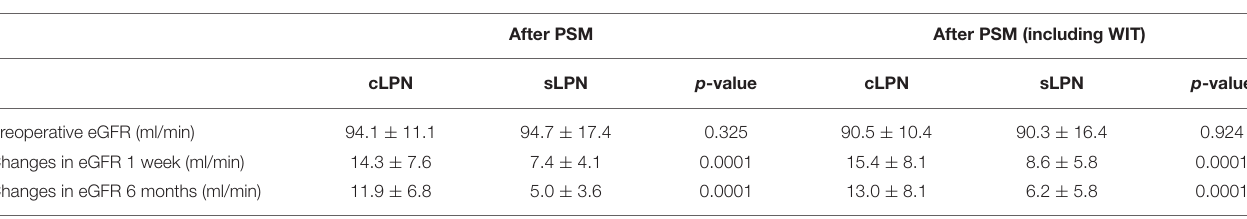
TABLE 4 | Preoperative eGFR and eGFR changes after